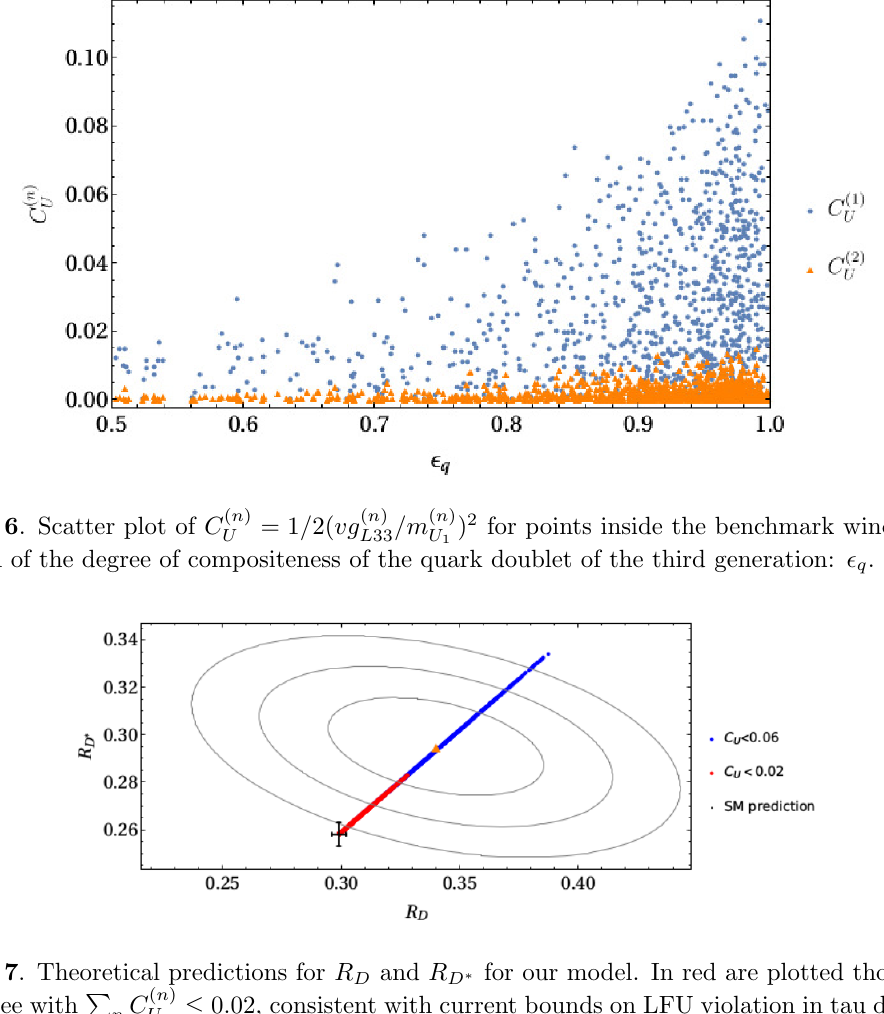
Figure 7 . Theoretical predictions for R D and R D (cid:3) for our model. In red are plotted those points that agree with P C ( n ) (cid:20) 0 : 02, consistent with current bounds on LFU violation in tau decays. In U n blue, we plot the rest of points, up to P C ( n ) = 0 : 06. Also plotted is the experimental point along U n with the con(cid:12)dence ellipses for coverage probabilities of 68.27%, 95.45% and 99.73% (1 to 3 (cid:27)